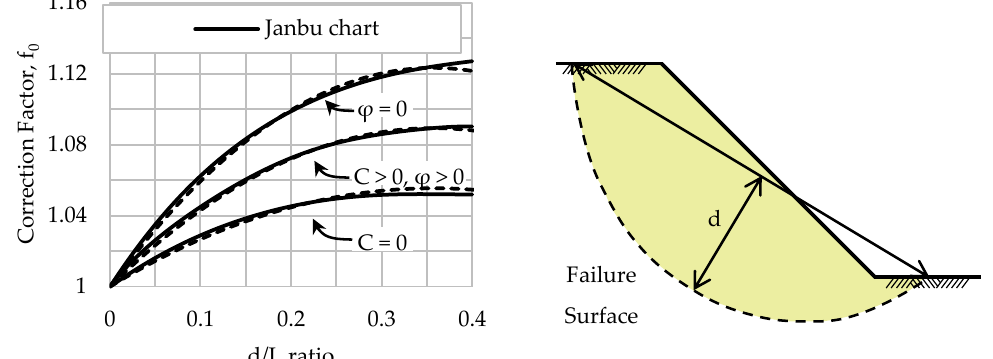
Figure 8. Correction factor for Janbu’s simplified method [31,102] .